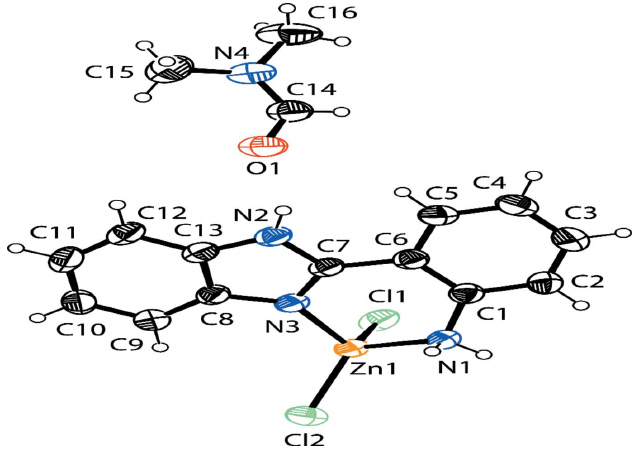
Figure 1 A view of the title complex with the atom labeling and displacement ellipsoids drawn at the 40% level.